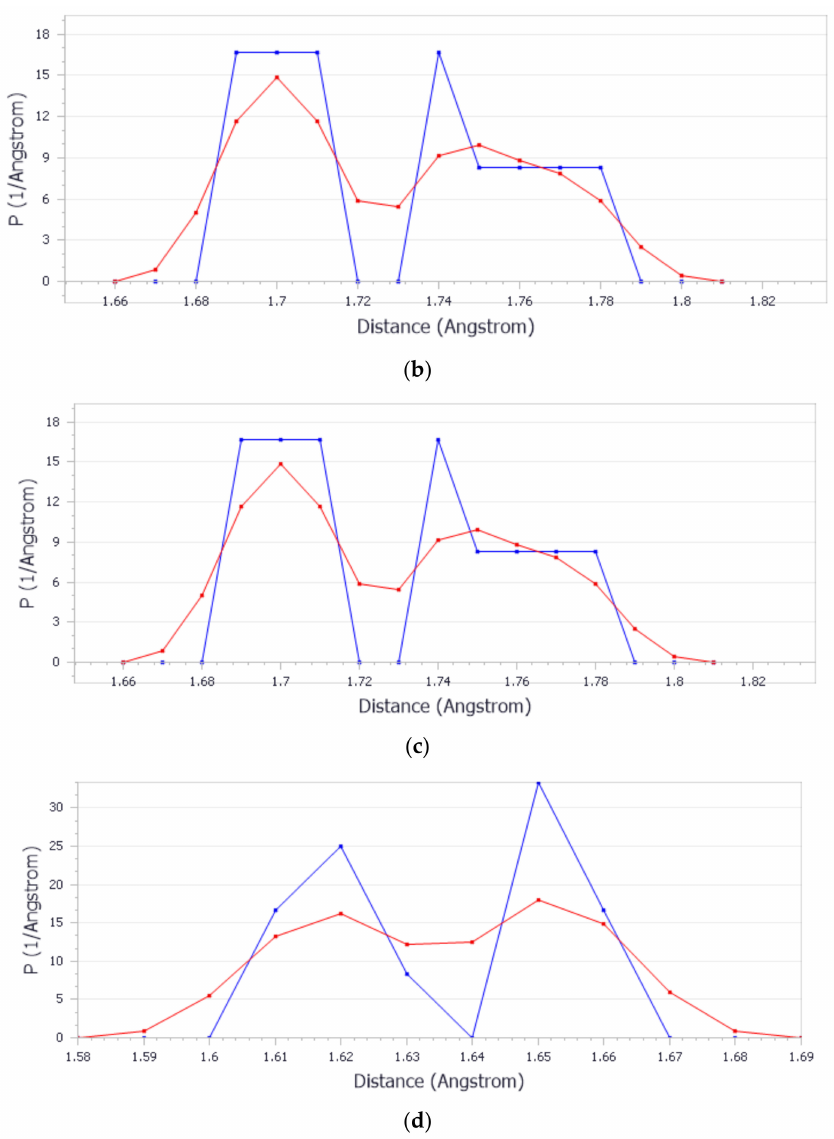
Figure 3. The change graph of bond length. ( a ) The simulation graph at low temperature and low voltage; ( b ) the simulation graph at low temperature and high voltage; ( c ) the simulation graph at high temperature and low voltage; ( d ) the simulation graph at high temperature and high